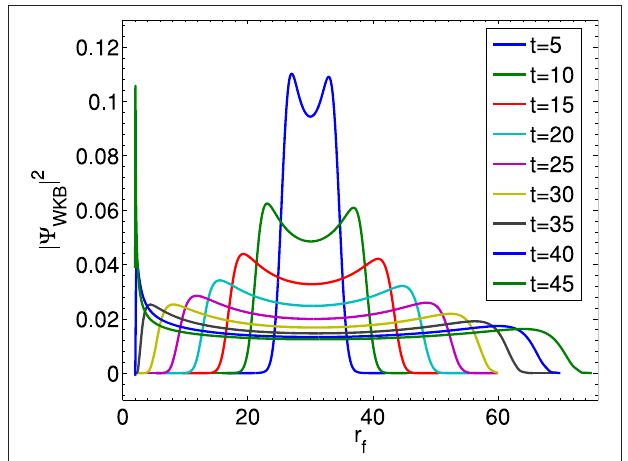
FIGURE 4 | The time evolution of WKB | 9 ( r f , t f ) | 2 is shown from t = 5 M to t = 45 M in the case of mM / ¯ h = 1. We can see that the star collapses to a black hole.